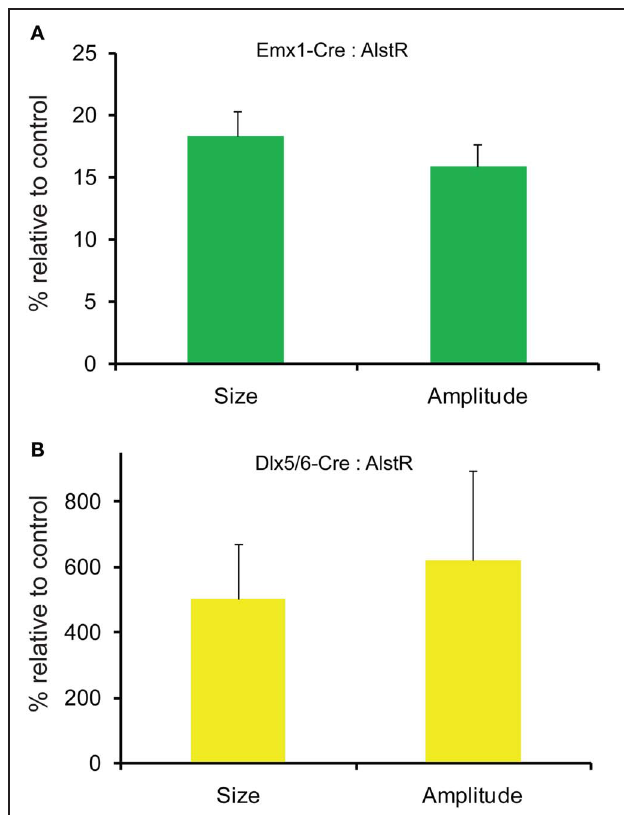
FIGURE 6 | Quantification of photostimulation-evoked responses in Emx1-Cre: AlstR and Dlx5/6-Cre: AlstR mouse slices. (A) Bar graph indicating the average activation size and response amplitude in the presence of AL for Emx1-Cre: AlstR slices ( N = 4), relative to normal ACSF control. (B) Bar graph indicating the average activation size and response amplitude in the presence of AL for Dlx5/6-Cre: AlstR slices ( N = 4), relative to normal ACSF